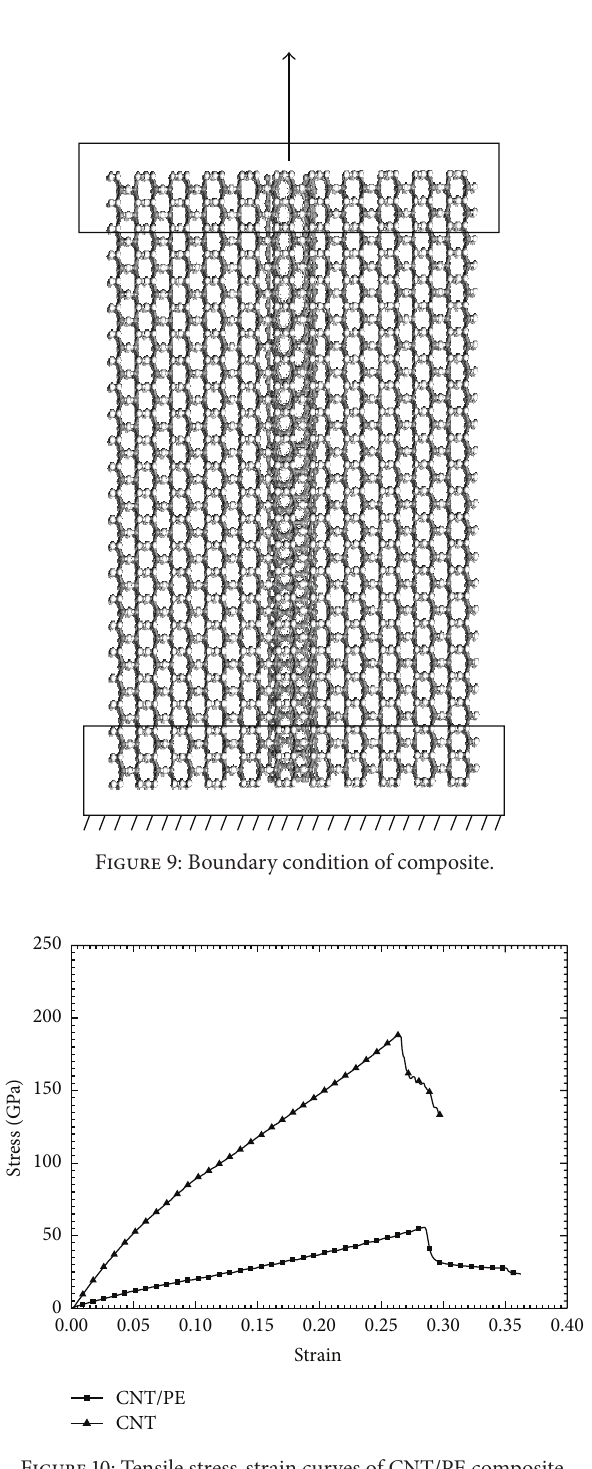
displacement boundary condition will induce a uniform ten- sion in the CNT and PE. The uniaxial stress-strain curve of the composite can be obtained by MD simulation.